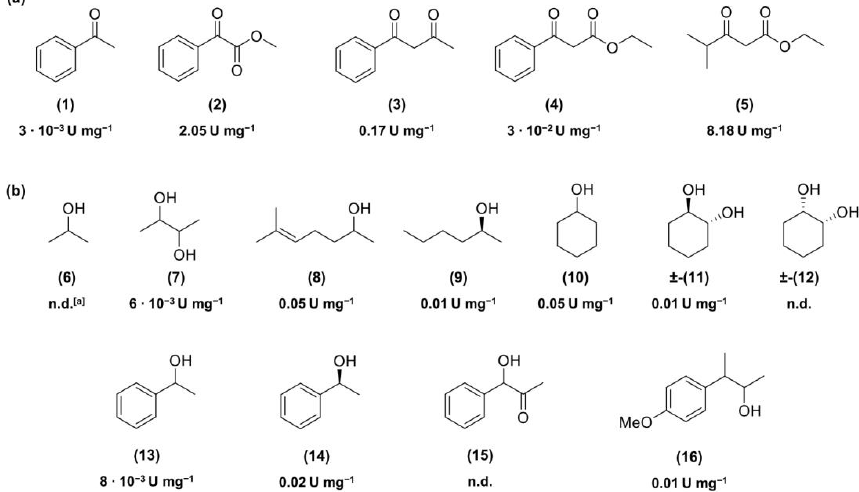
Figure 2. Substrates tested in s pectrophotometric assays for the Is2-SDR-catalyzed reduction ( a ) or oxidation ( b ) in the presence of NADP(H) cofactor. Specific activity (U mg − 1 ) values under standard oxidation ( b ) in the presence of NADP(H) cofactor. Specific activity (U mg −1 ) values under standard conditions are reported. [a] n.d.: below detection limit. conditions are reported. [a] n.d.: below detection